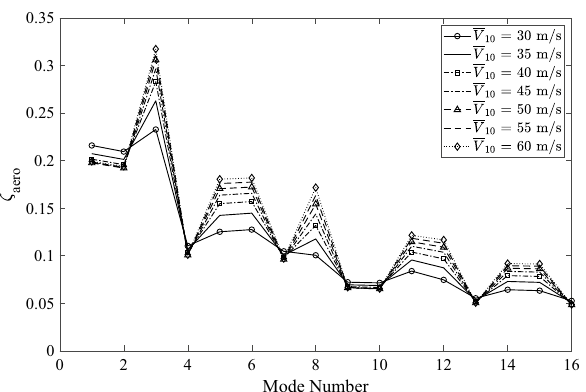
Figure 10. Comparison of aerodynamic damping